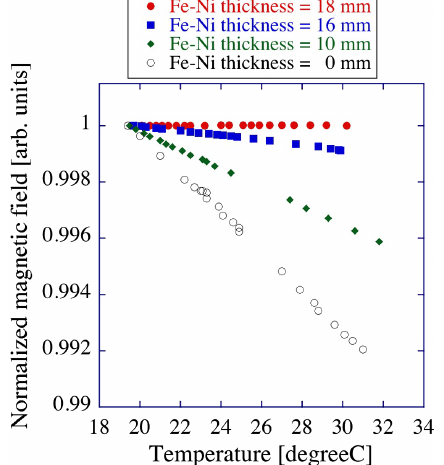
FIG. 4. Temperature dependence of magnetic field on beam axis for different thicknesses of Fe-Ni